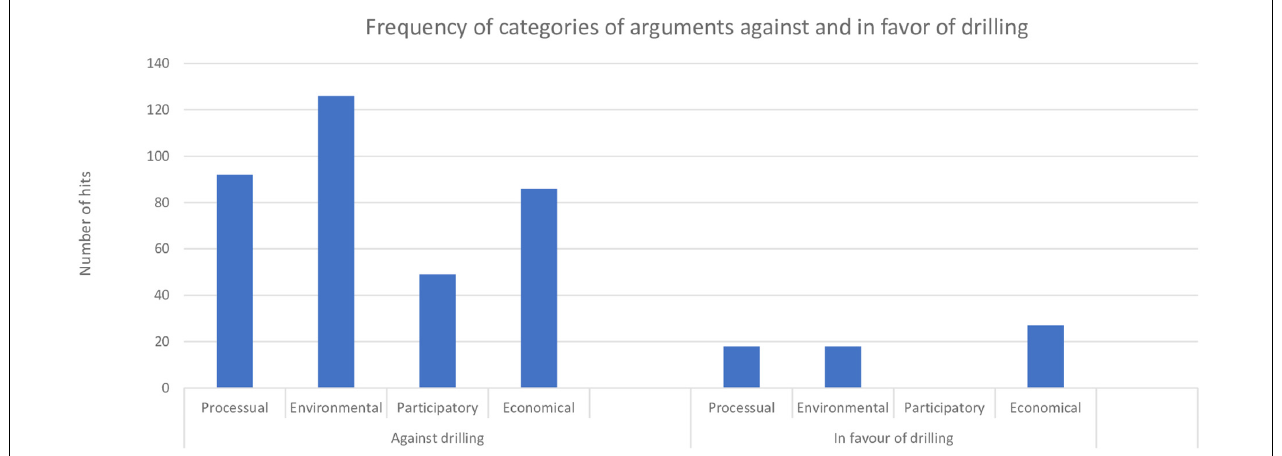
FIGURE 2 | Frequency of categories of arguments against and in favour of